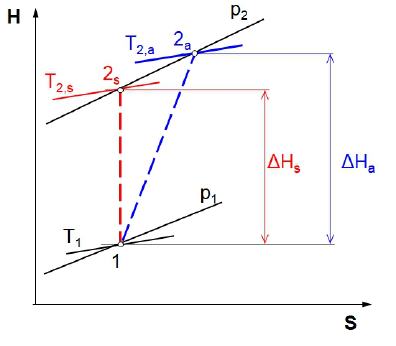
Figure 2. Isentropic and actual processes in H − S